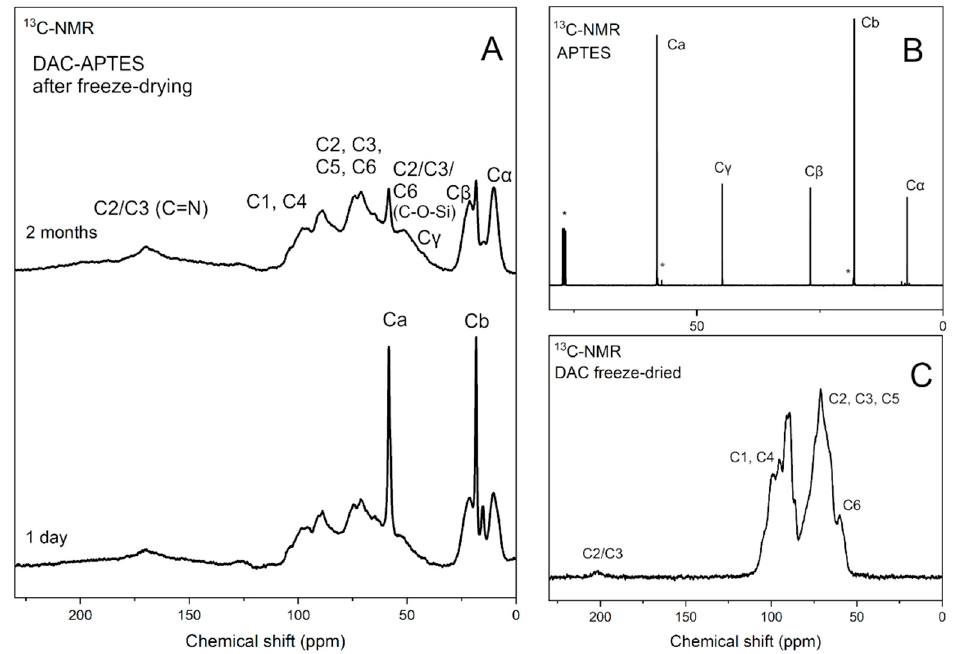
Figure 5. ( A ) 13 C CP / MAS NMR spectra of DAC-APTES freeze-dried after one day and after two months, the numbering referring to the structures indicated in Scheme 1: C1–6 from the DAC, a-b and α - β - γ from APTES structures. For the spectrum after two months, δ : 170.4, 98.3, 89.0, 74.1,